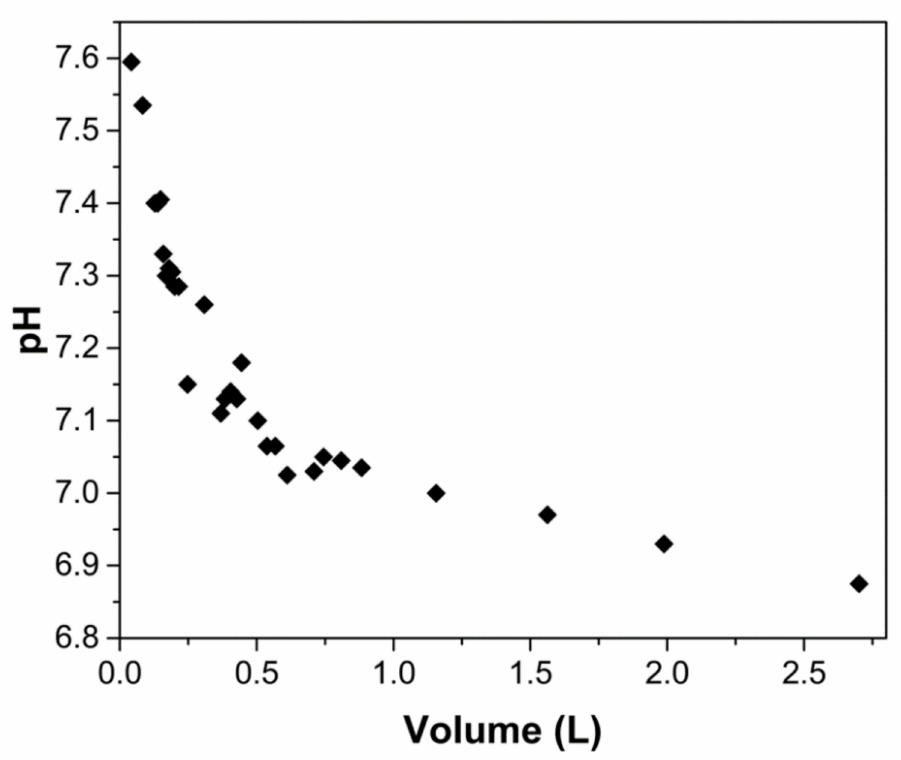
Figure 8. pH of the effluent solution using a 13 cm-high column packed with ChM hydrogel beads. Arsenate solution was fed at a rate of 8.5 mL/h, having an initial pH of 7.0 and a concentration of 5 mg